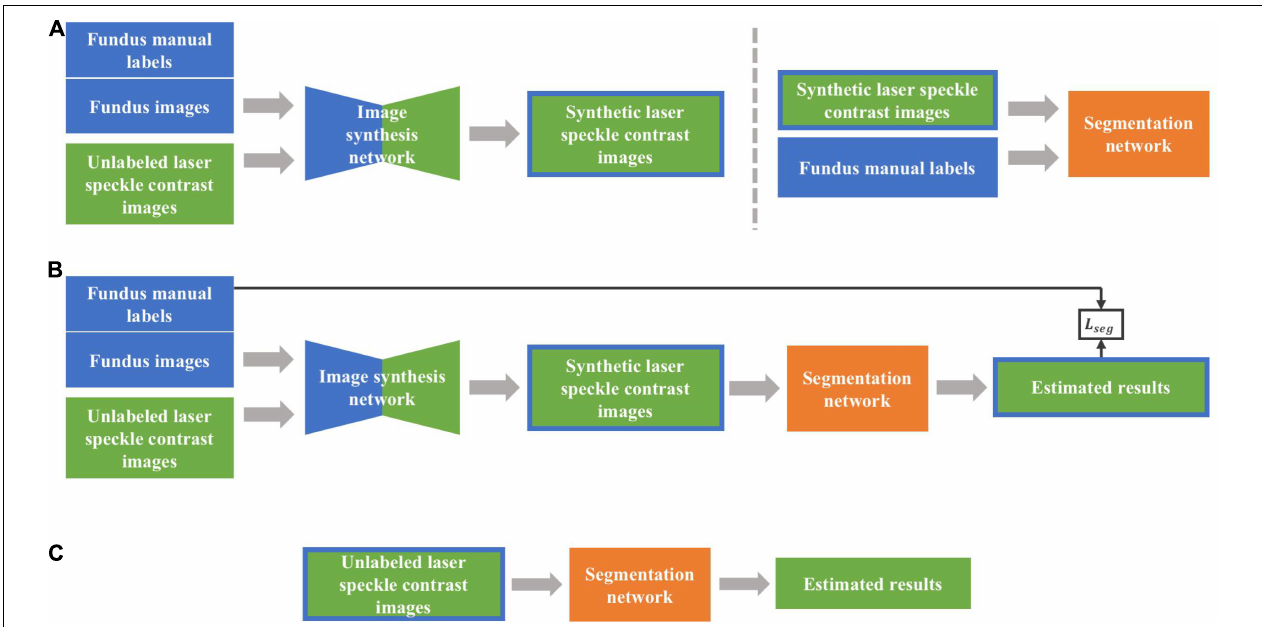
FIGURE 4 | The overall framework of the proposed method. (A) Two-stage training approach. First, synthetic laser speckle contrast images were obtained by training an image synthesis network with labeled fundus images and unlabeled laser speckle contrast images. Then, the synthetic laser speckle contrast images and fundus manual labels were used to train a segmentation network. (B) End-to-end training approach. The image synthesis network and segmentation network were jointly trained, and the obtained segmentation loss was backward propagated to optimize the two networks. (C) Testing stage. The trained segmentation network was applied to unlabeled laser speckle contrast images to obtain the segmentation